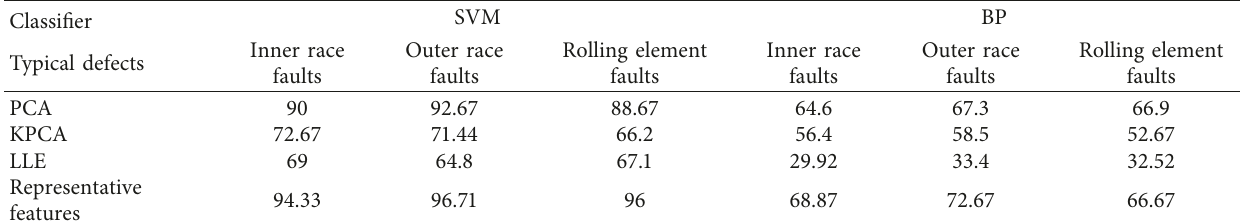
Table 8: Performance comparison of fault classification with different feature selection schemes. Classifier